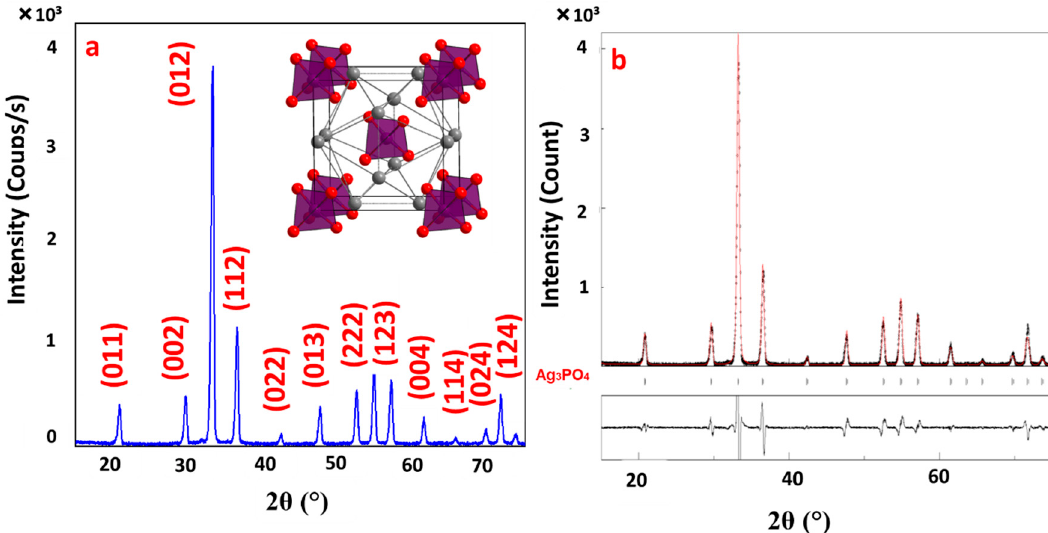
Figure 1. XRD spectrum: Identified atomic plane of the Ag 3 PO 4 phase ( a ), rietveld refinement of the